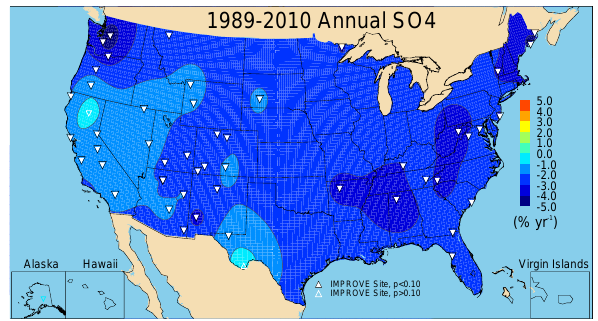
Fig. 1. IMPROVE 1989–2010 trends (% yr − 1 ) in annual mean particulate sulfate ion concentrations. Triangles correspond to IM- PROVE sites; upward pointing triangles correspond to increased concentrations and vice versa. Trends with significance levels ( p ) less than 0.10 are considered